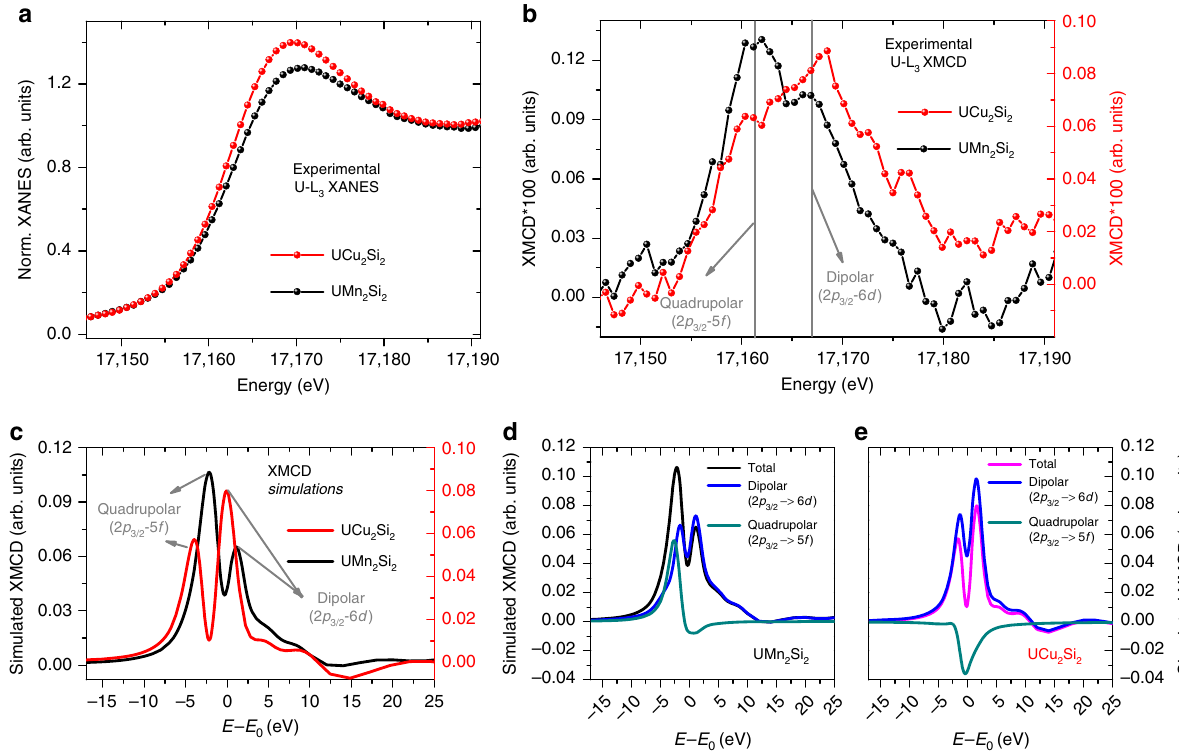
Fig. 1 Uranium L 3 edge spin-dependent X-ray absorption spectroscopy. a X-ray Absorption Near Edge Structure (XANES) and b X-ray Magnetic Circular Dichroism (XMCD) measurements for UCu 2 Si 2 and UMn 2 Si 2 performed at temperatures of 10 K and 300 K, respectively. In c are shown the corresponding ab initio simulations for both compounds. A small difference in the integrated area under the main XANES peak (so called white line) is observed between the two compounds, indicating UCu 2 Si 2 presents a higher density of unoccupied states above the Fermi level than UMn 2 Si 2 , which may be an indication of the former being much less hybridized than the latter in agreement with the theoretical predictions 25 . The difference observed on XMCD experimental data for the ratio between the intensities of quadrupolar and dipolar intensities is very well reproduced in the simulated spectra and the explanation for this behavior is discussed in the main text. The individual contributions to the theoretical XMCD spectra are shown in d for the UMn 2 Si 2 compound and in e for the UCu 2 Si 2 . Interestingly, the amplitude ratio between the two XMCD peaks is opposite for the two compounds. As supported by the calculations of the dipolar/quadrupolar contributions shown in d and e , this difference is due to the fact that the dipolar contribution is almost the same for both compounds while the quadrupolar contribution has opposite sign between the two materials. Therefore, it is evident that the different 5 f -6 d degree of hybridization between these two compounds, de fi ning their Fermi level position, is responsible for the relative alignment between 5 f and 6 d moments, which is also consistent with LDA + U simulations used to estimate the 5 f /6 d moments (Supplementary Note